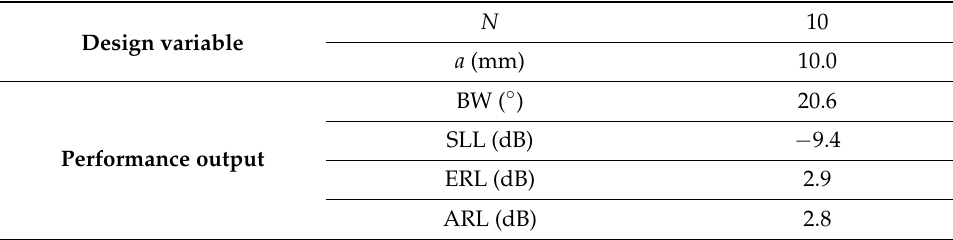
Table 6. Final structure of the SA